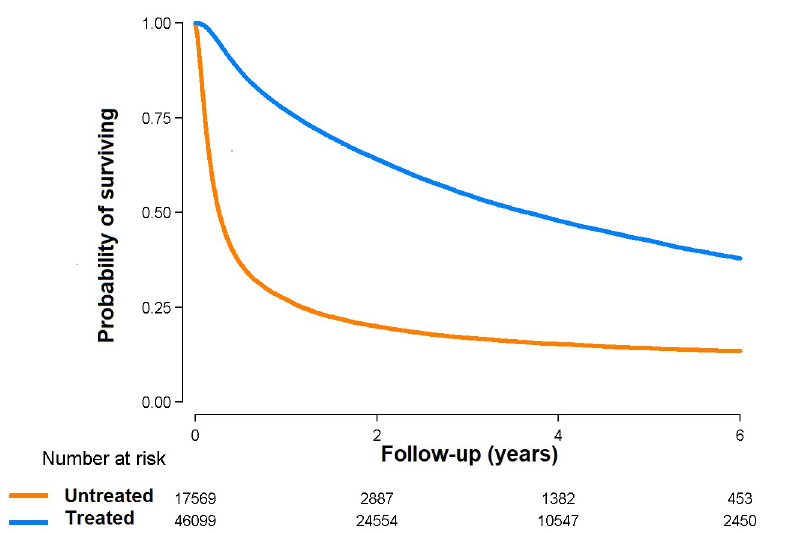
Fig 1. Overall survival from diagnosis of hepatocellular carcinoma by treatment status (N =